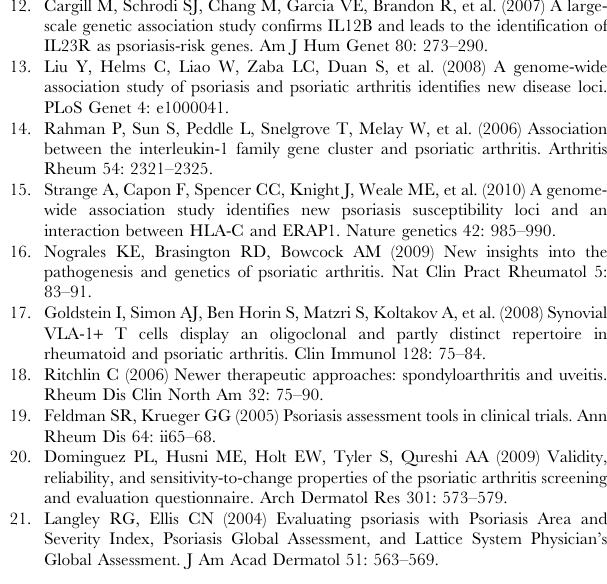
Figure S2 Psoriatic Arthritis Screening and Evaluation (PASE) is a validated patient questionnaire that com- prises questions on symptoms and functions. Figure S3 Nail Assessment (NA) and Joint Assessment (JA) evaluates nail involvement (score 0 for no involve- ment and score 1 for involvement by digit) and joint involvement (0/1 by digit) on the hands, as determined by physician assessment. Figure S4 Psoriasis Weighted Extent and Severity Index (PWESI) is used to evaluate the extent and severity of skin disease across multiple areas of the body. The extent of skin disease is measured on a scale of 0 (none) to 4 (extensive) and severity of disease on a scale of 0 (essentially clear) to (intensely